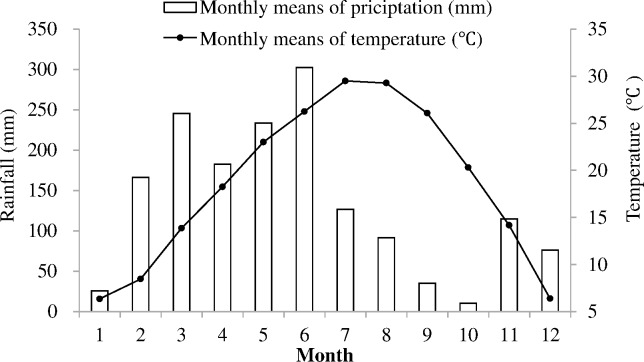
The average monthly rainfall (mm) and temperature (°C) in 2013–2014.